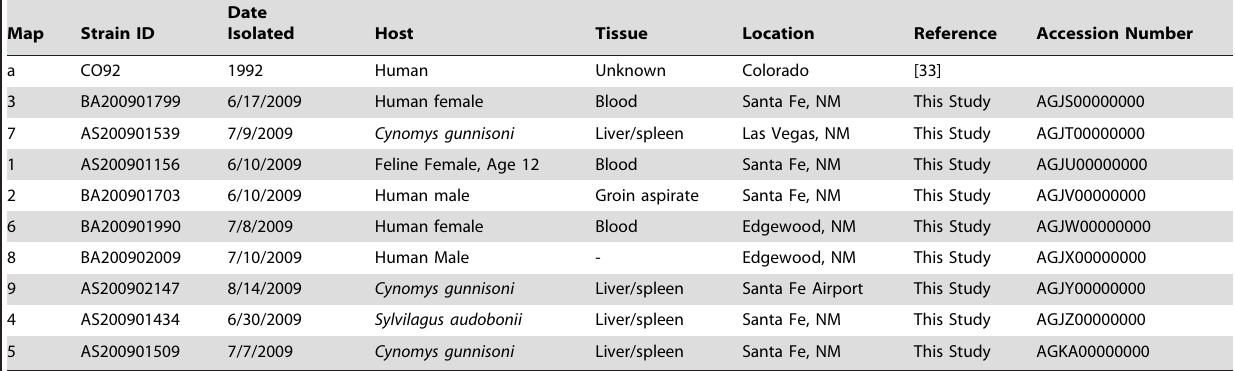
Table 1: 2009 New Mexico Plague Isolate Data Map